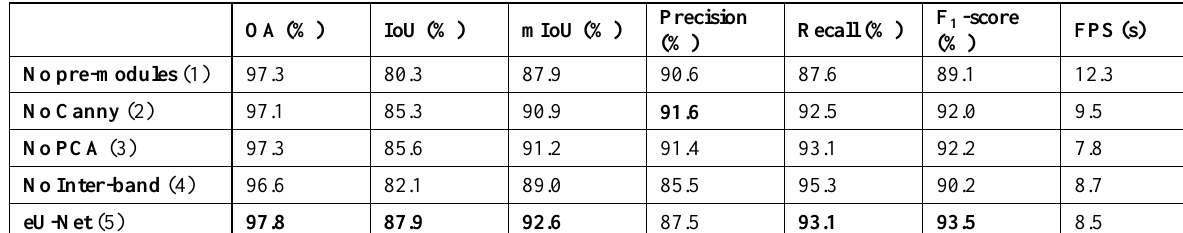
Table 2. Results of ablation experiments